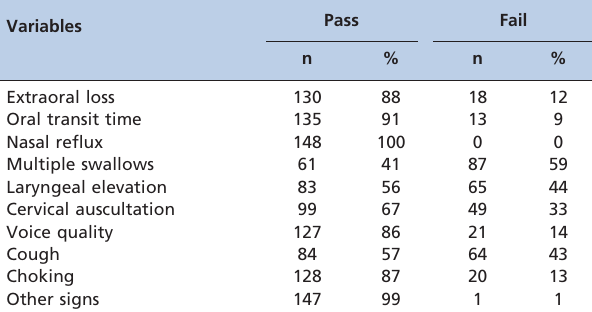
Table 2 - The water swallow test results.